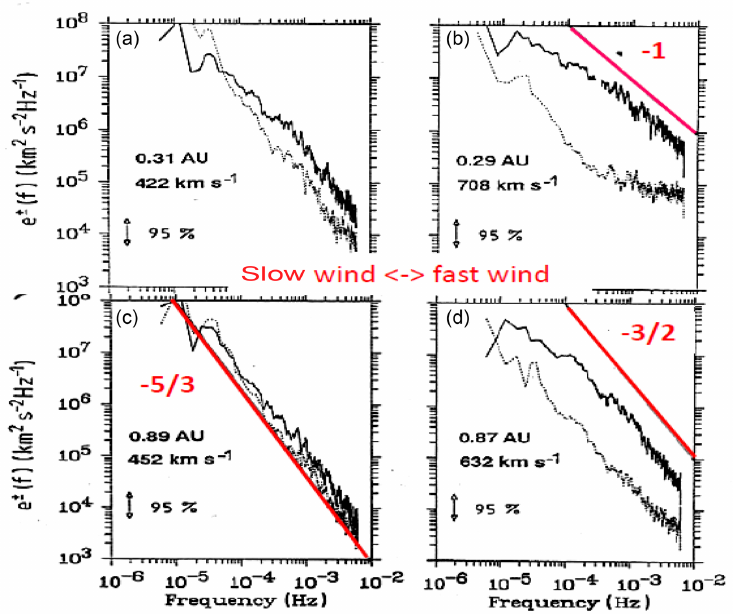
Figure 7. Dependence on radial solar distance (Marsch and Tu, 1990a) of the energy spectra of outward- ( e + , continuous curves) and inward-propagating ( e − , dotted curves) Alfvén waves as measured by Helios in slow (a, c) and fast (b, d) solar wind. The frequency axis of panels (a) and (b) is the same as for panels (c) and (d) . The theoretical spectral slopes and indices are given in red for comparison with the measured spectra. Note the distinct steepening of the e + spectrum in fast wind, indicating the radial evolution towards the Kolmogorov − 5 / 3 spectrum, and the predominance of outward-propagating Alfvén waves, i.e., e + (cid:29) e − . Turbulence in slow wind appears to be more developed near the Sun even at 0.31AU, and it is less